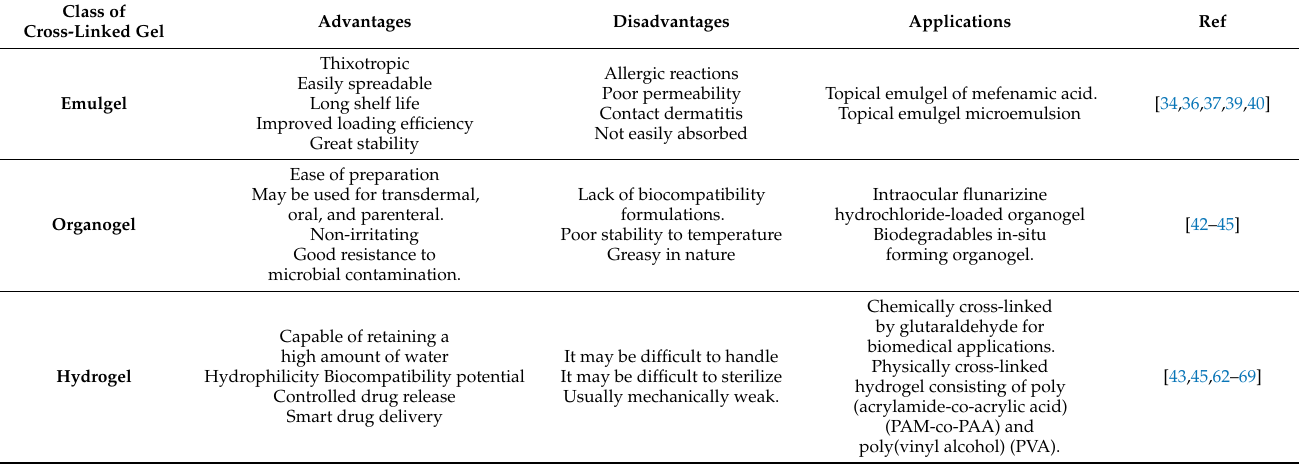
Table 1. Summary of cross-linked gels and